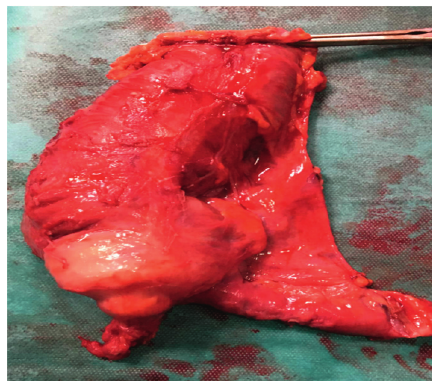
Figure 6: Right hemicolectomy for caecal mass.